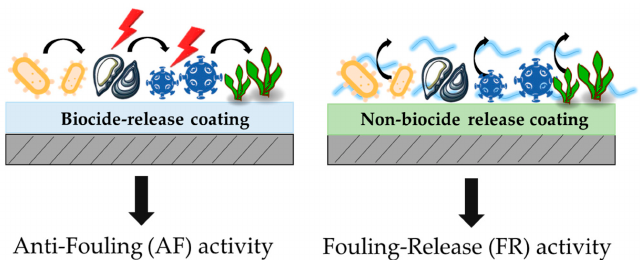
Figure 18. Antifouling and fouling-release activity of biocide-release and non-biocide-release coatings, respectively. Reproduced from MDPI Ref. [70].